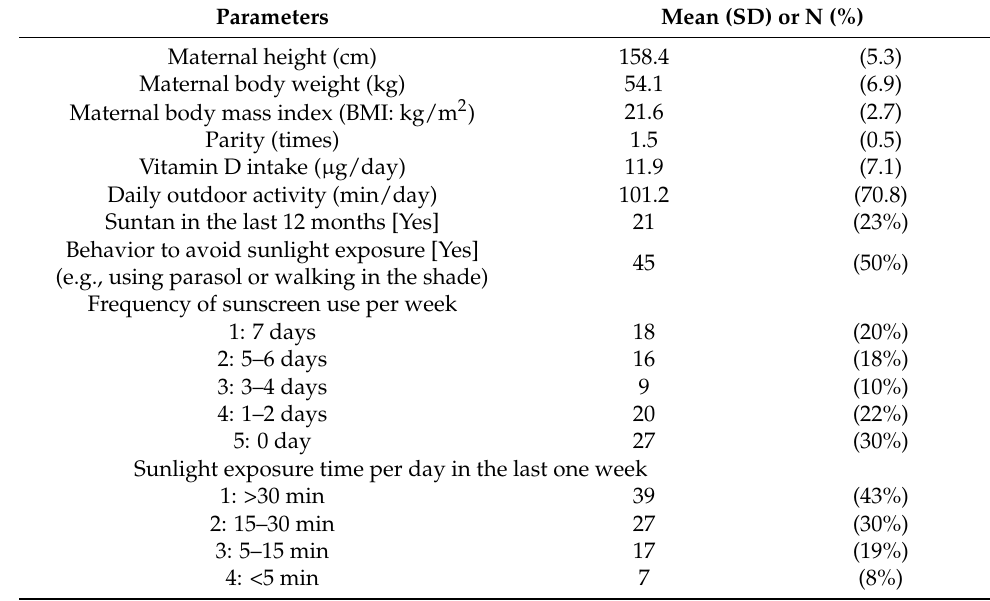
Table 3. Background characteristics of lactating mothers in 2016–2017.